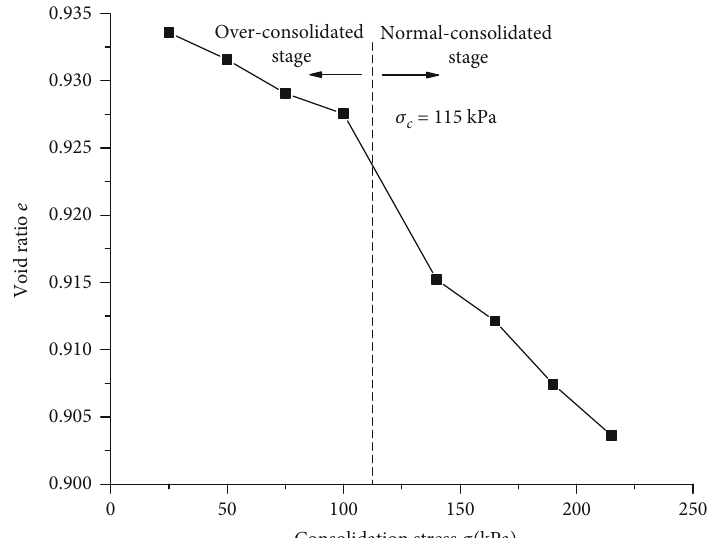
Figure 19: Variation curve of the void ratio with consolidation pressure during one-dimensional consolidation of normally and overconsolidation saturated clays.